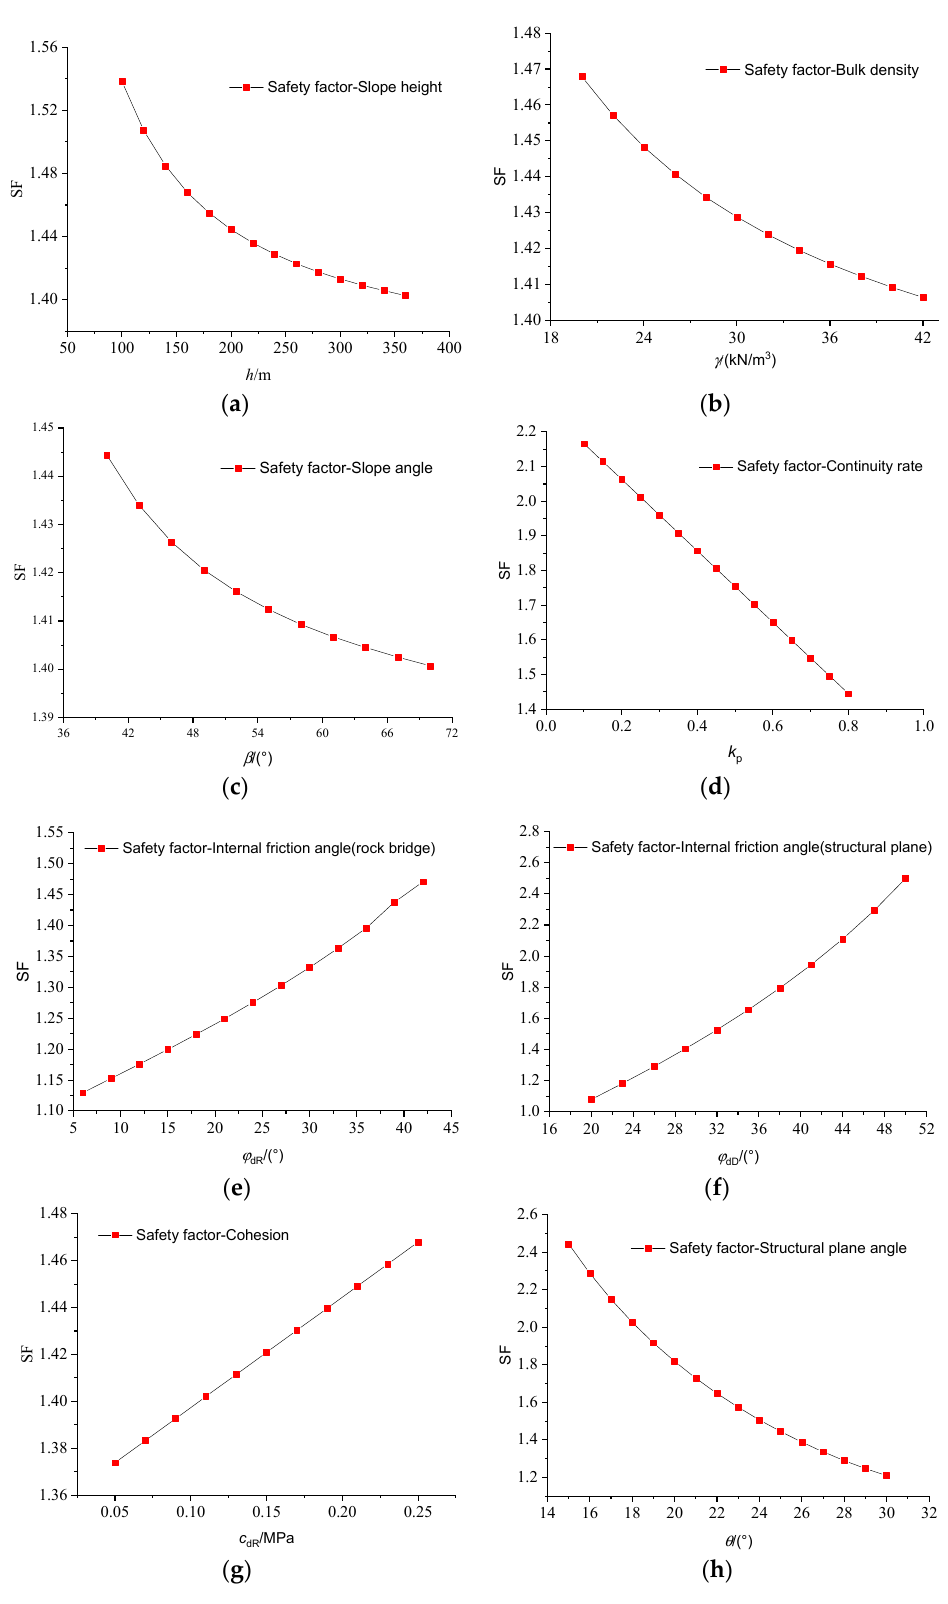
Figure 13. Relation curve between safety factor and different parameters. ( a ) slope height, ( b ) bulk